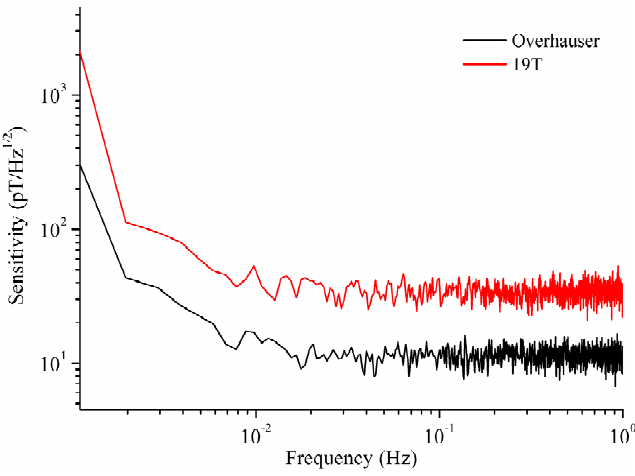
Figure 15. Sensitivities of our sensor and GSM-19T.